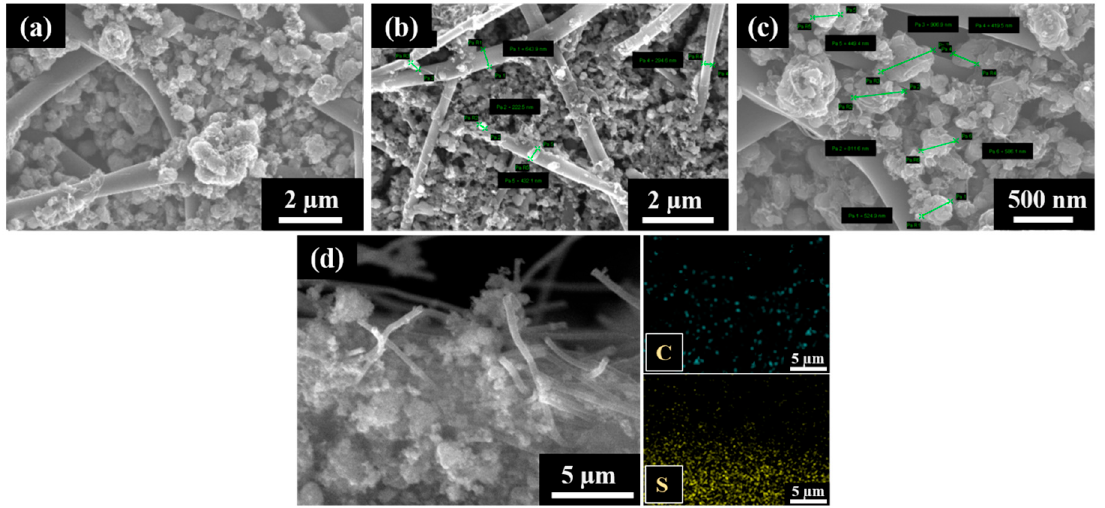
Figure 4. ( a ) SEM images of the sulfur/dehydrogenated polyacrilonitrile/carbon nanotube (S/DPAN/CNT) composite cathode on the carbonized polyacrylonitrile nanofibers (cPAN) carbon nanofiber (CNF) current collector, ( b , c ) cross-section views and ( d ) SEM/EDS mapping showing the distribution of S and C in the cross-section view of the electrode.